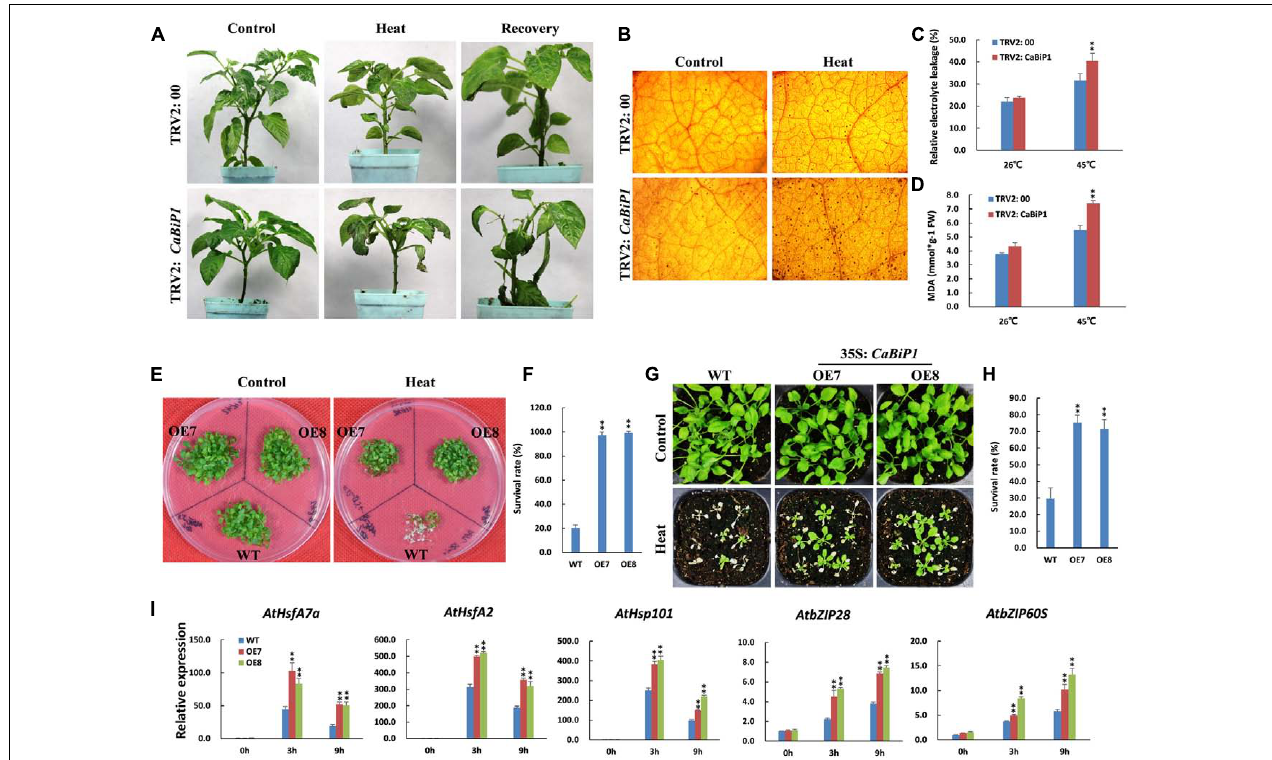
FIGURE 7 | Altered heat tolerance in CaBiP1 -silenced and CaBiP1 -overexpressing plants. (A) TRV2: CaBiP1 and TRV2:00 pepper seedlings following heat stress at 45 ◦ C for 24 h and recovery for 5 days under 25 ◦ C normal conditions. Plants continually grown at 25 ◦ C were used as controls. (B–D) H 2 O 2 accumulation,REL and MDA content in pepper seedlings leaves treated with 45 ◦ C heat stress for 24 h. (E,F) Survival rate of 7-day-old WT and CaBiP1 -OE Arabidopsis seedlings submerged in a 45 ◦ C water bath for 50 min and recovered at 22 ◦ C for 5 days. (G,H) Survival rate of 2-week-old Arabidopsis seedlings in soil after treatment at 45 ◦ C for 6 h then recovered for 5 days. (I) Expression of ER stress- and heat stress-related genes in 3-week-old WT and CaBiP1 -OE Arabidopsis seedlings treated at 45 ◦ C for the designed time duration. AtActin2 was used as the internal control. Data are the mean ± standard deviation from three biological replicates. Statistical significance is indicated by a single asterisk ( p < 0.05) and a double asterisk ( p < 0.01) based on the results of the student’s t